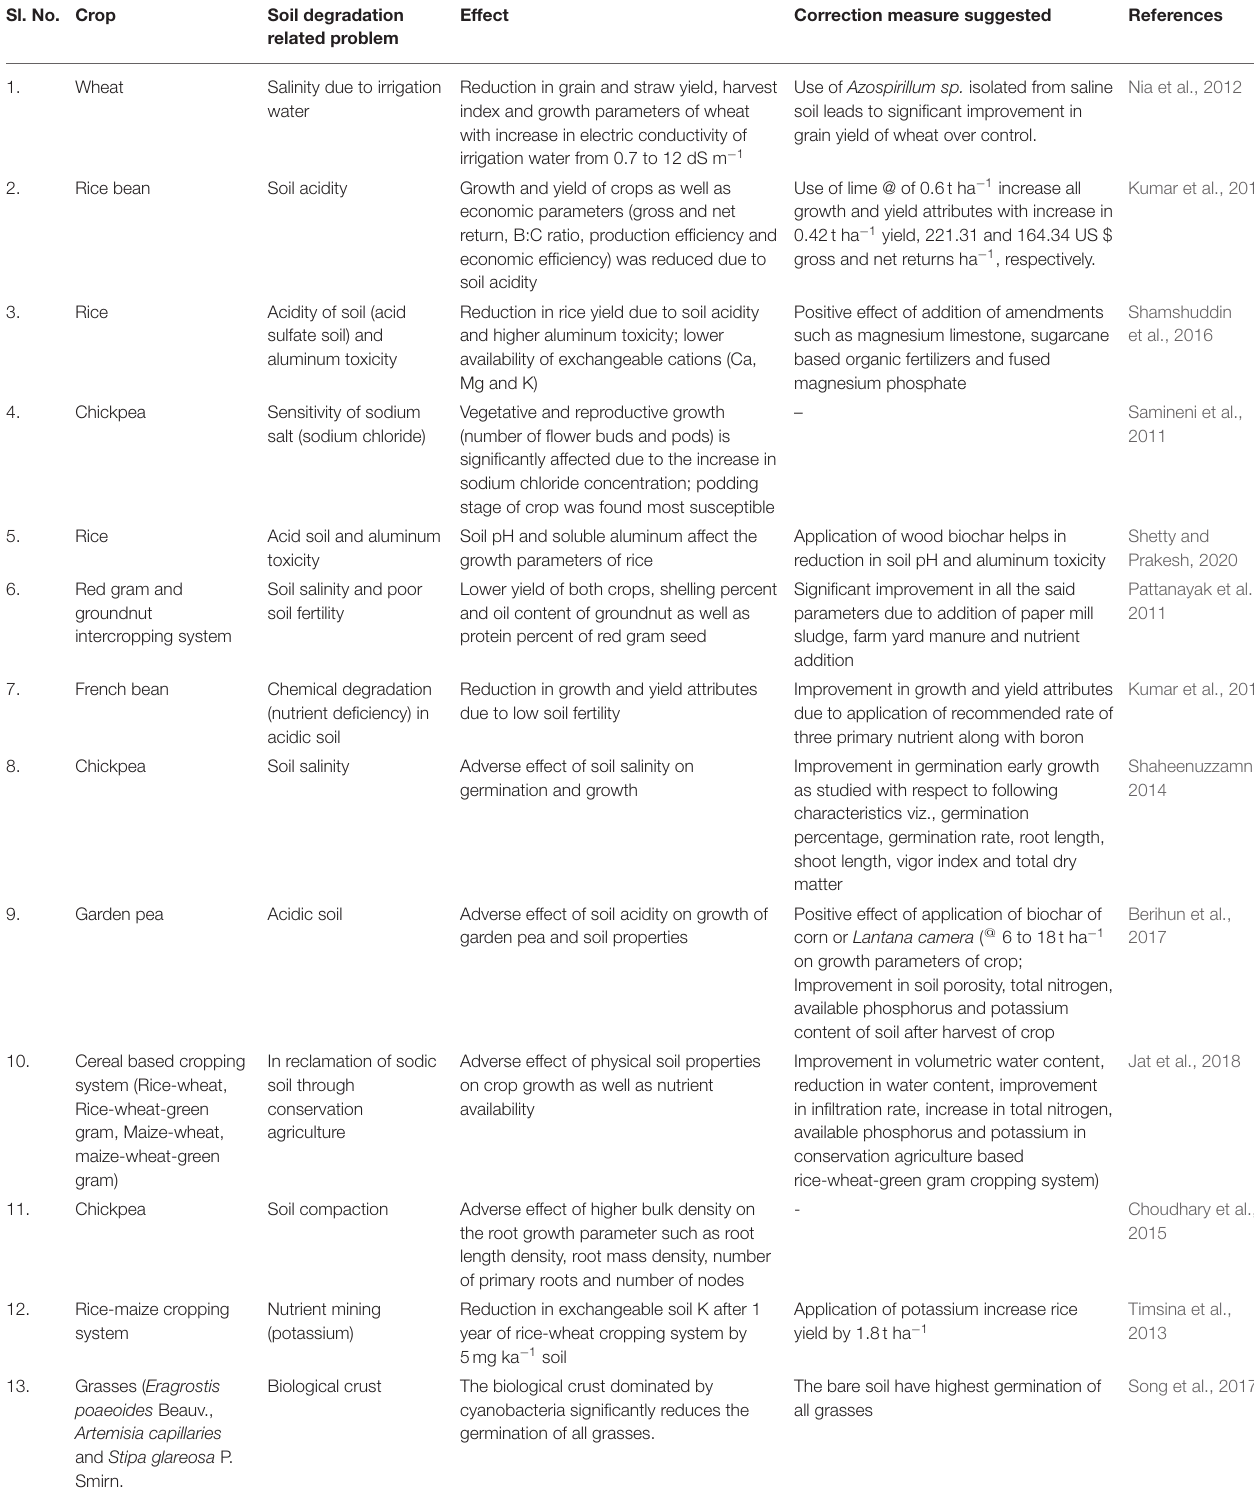
TABLE 8 | Effects of soil degradation on crop growth and productivity. Sl. No.